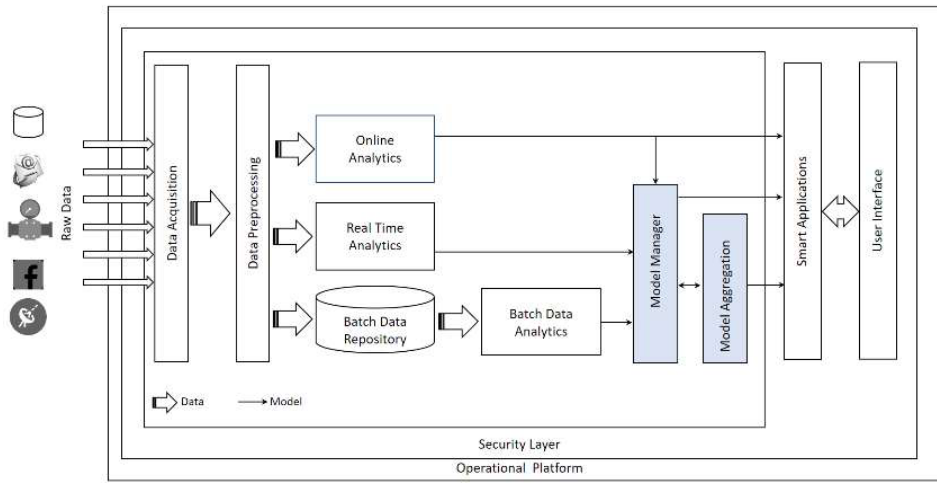
Figure 4. SCDAP conceptual design schematic diagram [10].